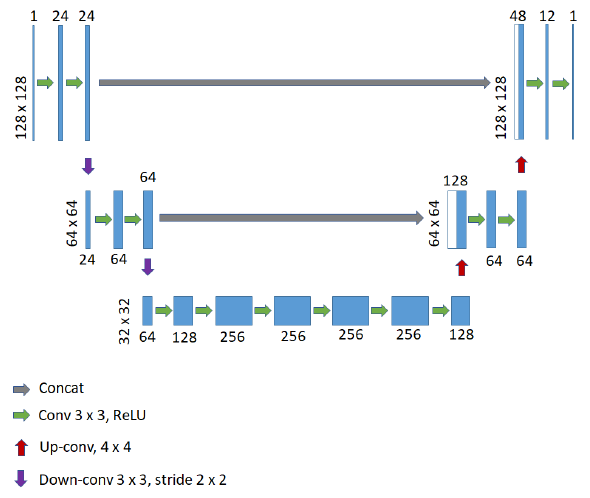
Figure 1. Model architecture for our building generalization network